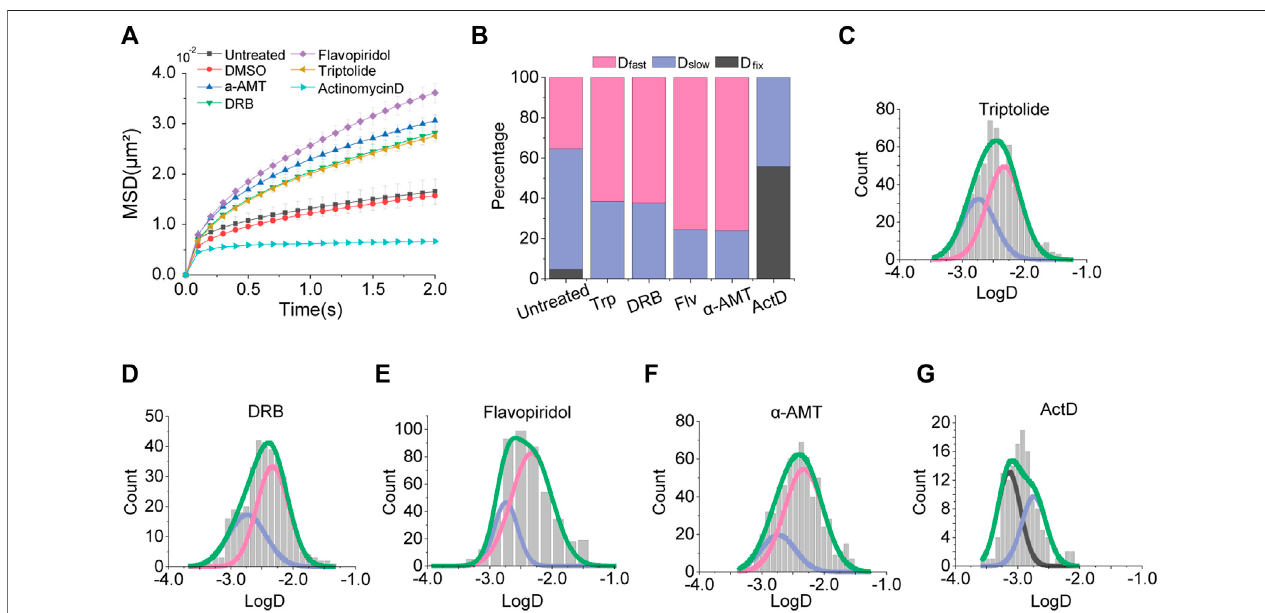
FIGURE 2 | Effects of transcription inhibitors. (A) Averaged MSD-t plots for each time interval is normally cultured cells and transcription inhibitor treated cells. (triptolide, N = 27 cells, n = 633 trajectories; DRB, N = 22 cells, n = 370 trajectories; fl avopiridol, N = 30 cells, n = 501 trajectories; a-amanitin, N = 33 cells, n = 671 trajectories; actinomycin D, N = 33 cells, n = 633 trajectories) (B) Percentages of diffusion constant components from multimodal Gaussian fi ttings for each condition. (C – G) Distributions of diffusion constants for individual trajectories in cells treated with triptolide, DRB, fl avopiridol, a-amanitin, and actinomycin D, respectively. Green lines represent fi tting with triple Gaussian peaks for the entire distribution. Pink, blue, and black lines represent single Gaussian portions for fast, slow, and fi xed diffusions,